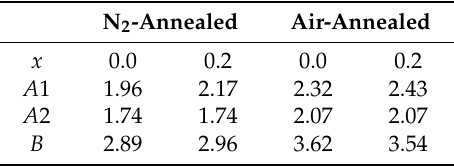
Table 3. Bond valence sums (BVS) for A 1, A 2, and B atoms for x = 0.0 and 0.2 in the crystal structures of N 2 - and air-annealed phases (NPD-data). Bond valence radii used; R 0 ( A ) = 2.118 Å (Sr 2+ ), R 0 ( B ) = 1.759 Å (Fe 3+ ) [19]. N 2 -Annealed 0.0